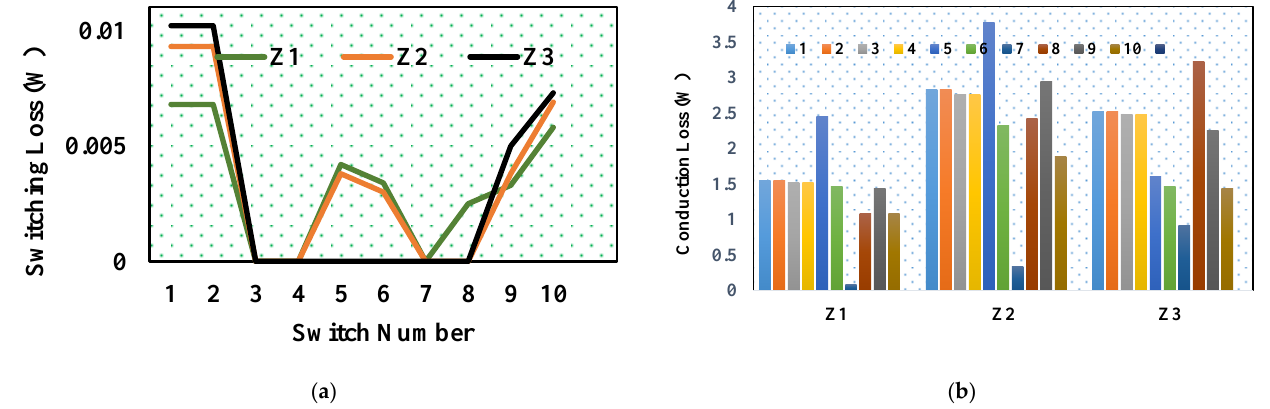
Figure 5. Loss distribution across switches ( a ) Switching Loss ( b ) Conduction Loss